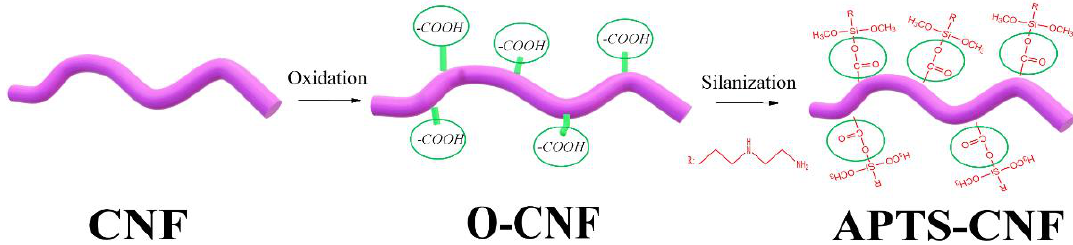
Figure 1. Schematic reaction of [3-(2-aminoethylamino)propyl]trimethoxysilane (APTS) silane coupling agent onto carbon nanofibers (CNF).